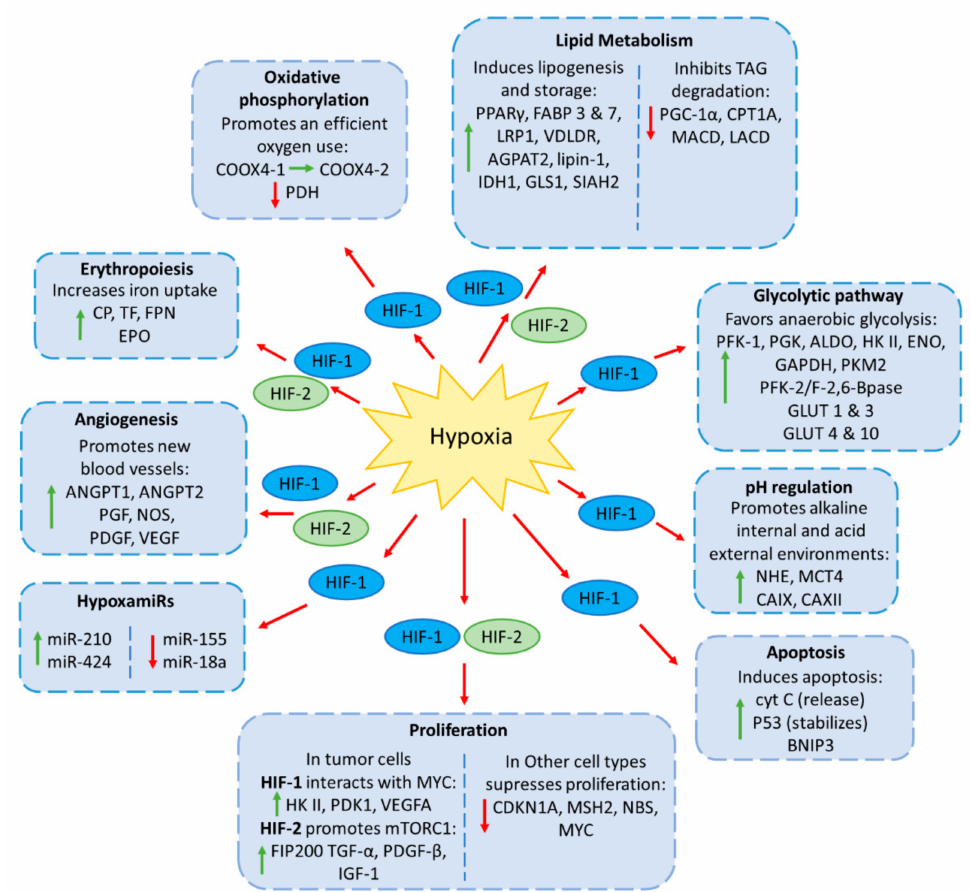
Figure 1. Cellular response to hypoxia. Under conditions of low oxygen levels, cells respond to hypoxia through hypoxia- inducible factors 1 and 2 (HIF-1 and 2), which modulate several key cellular processes. HIF-1 upregulates oxidative phosphorylation by interacting with COOX4 to promote efficient oxygen use, and pyruvate dehydrogenase (PDH)